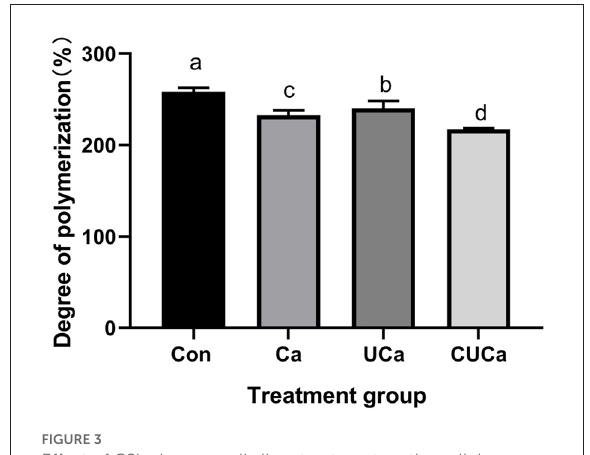
FIGURE3 Effect of CSL plus urea-alkali pretreatment on the cellulose degree of polymerization (DP) of rice straw. Con: no pretreatment for control group, Ca: 4% CaO, UCa: 2.5% urea + 4% CaO, CUCa: 9% CSL + 2.5% urea + 4% CaO. Different superscript letters a, b, c, and d indicates significantly different values ( P < 0.05) in different groups, and the same or no letters indicate insignificant differences ( P >